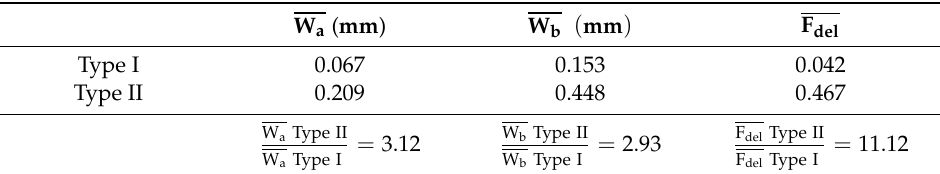
Table 6. Type I and II delamination comparison.